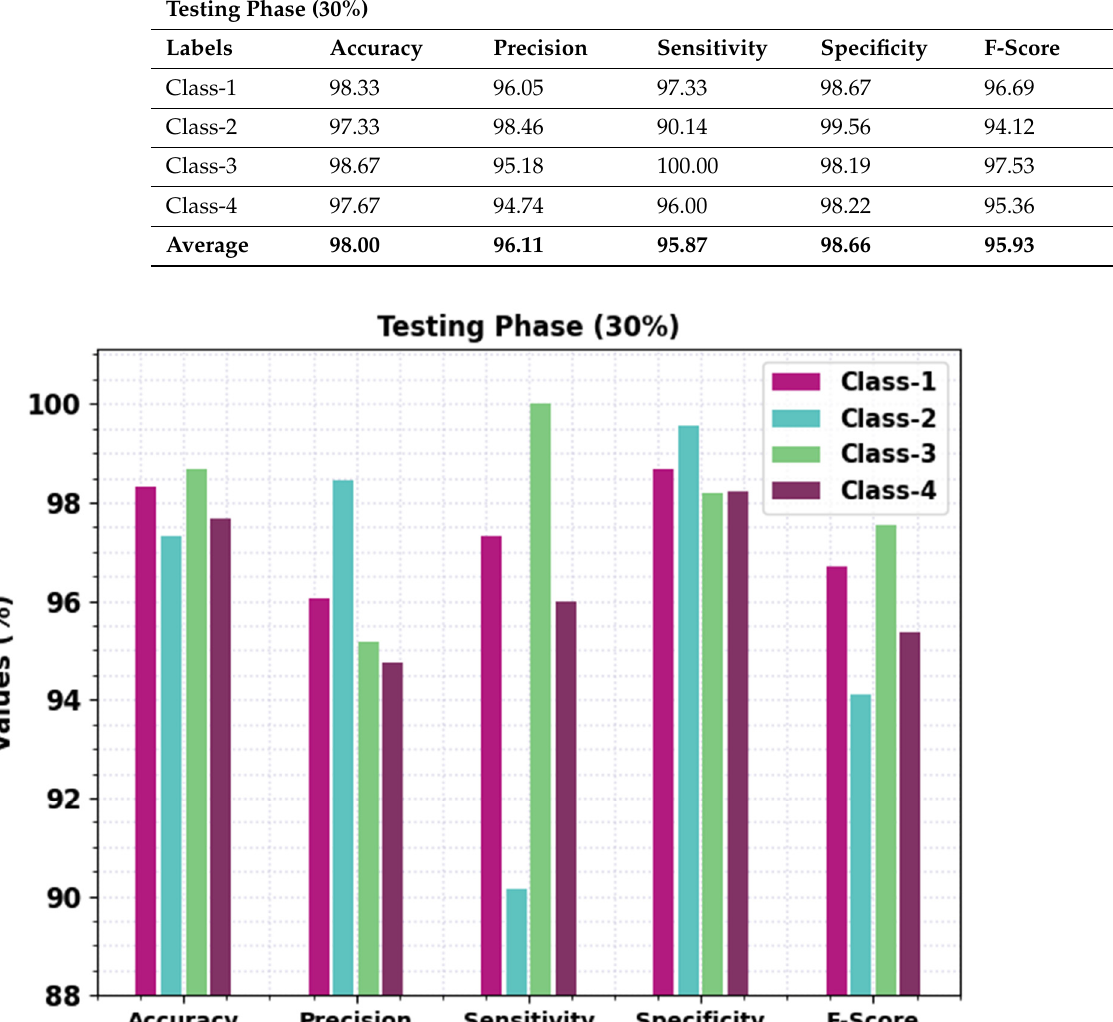
Table 4. Crowd classification outcome of the AOTL-CDA3S system with different measures under 30% of the TS database.